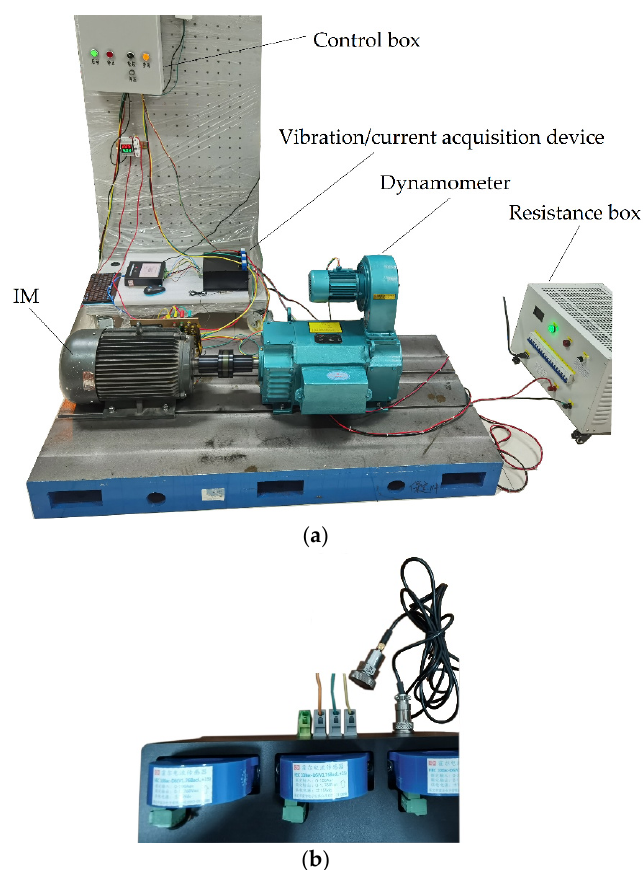
Figure 1. Test rig: ( a ) platform and ( b ) acquisition device and sensors. Table 2. Rated values and bearing types of tested motors.